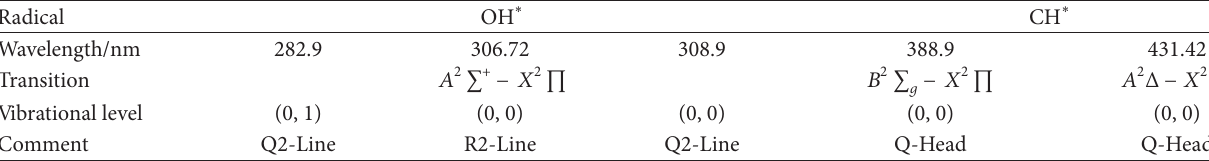
T 3: Radiation data of the major excited radicals.